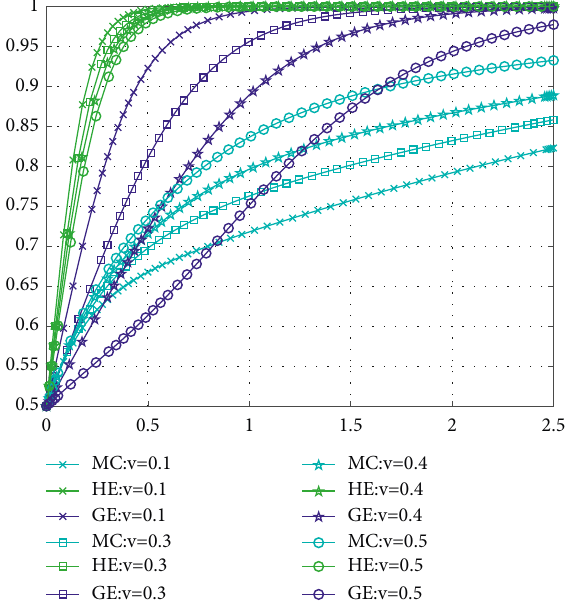
Figure 6: Evolution result of changes in technology spillover